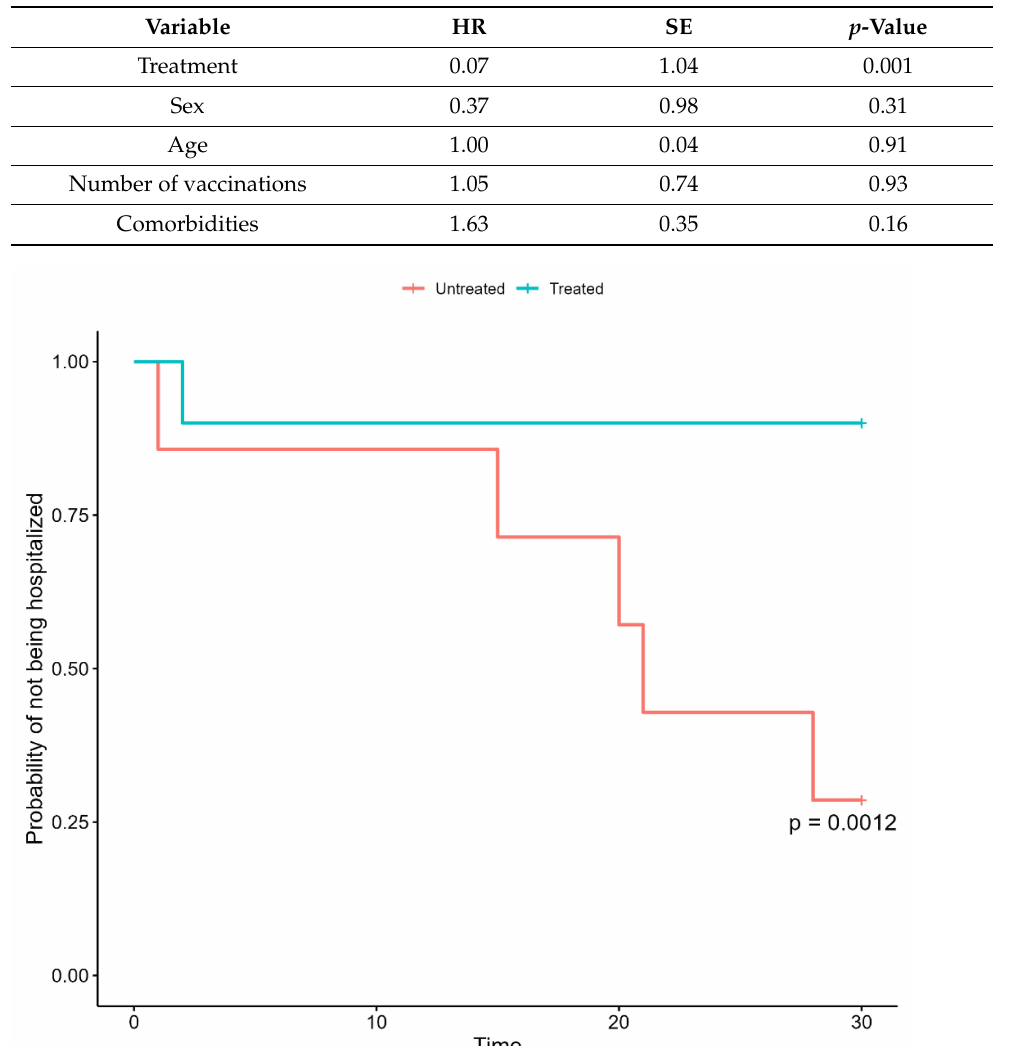
Table 4. Multivariate Cox regression for 28-day hospital admission of patients with hematologic malignancies with negative anti SARS-CoV-2 antibodies.